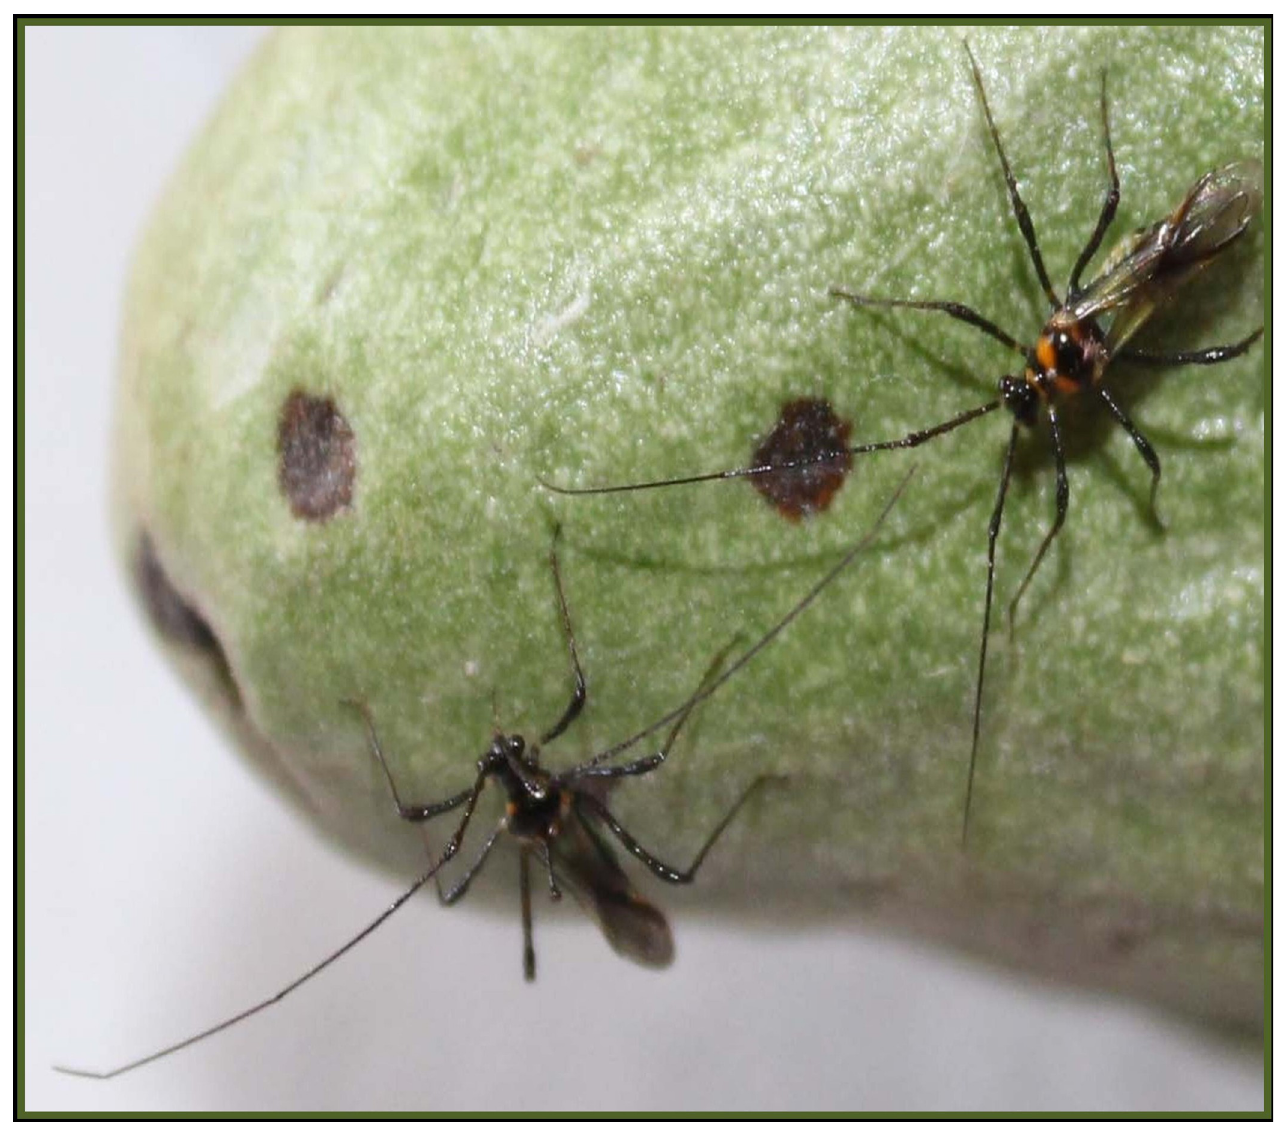
Fig 2. Screening on